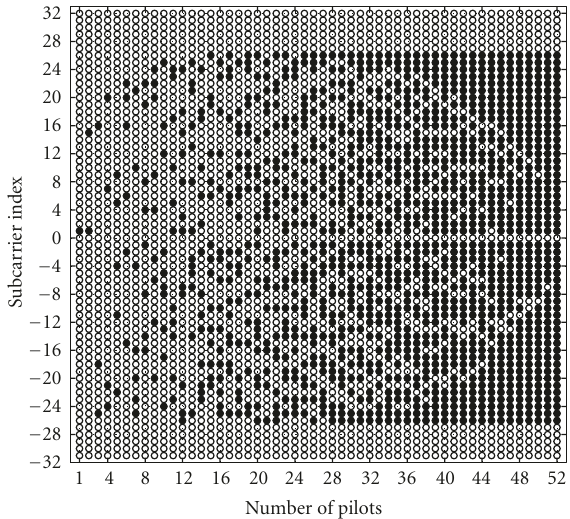
Figure 10: Pilot locations that minimize the ACF sidelobe peak for constrained search.